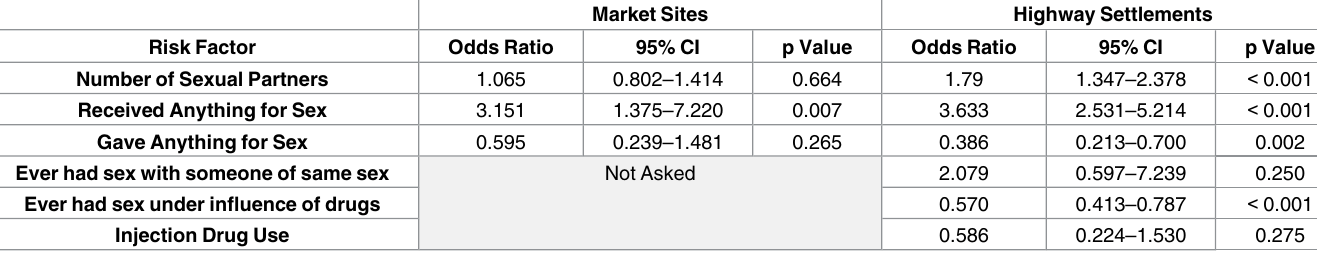
Table 3. Unadjusted Odds Ratios for Selected Behavioral Risk